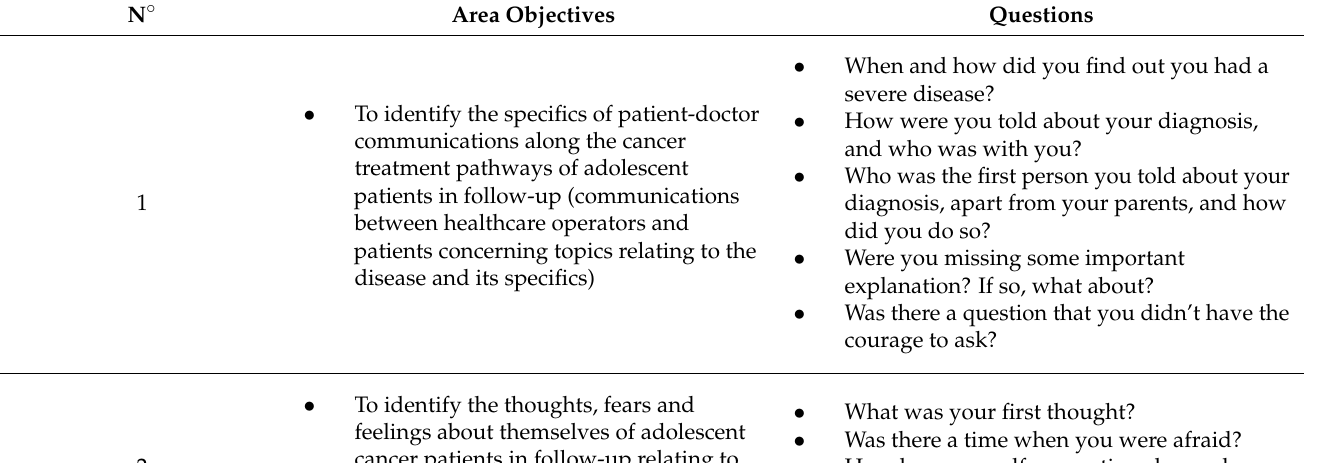
Table 1. Questions posed to patients in the interview, covering the objectives of the four macro